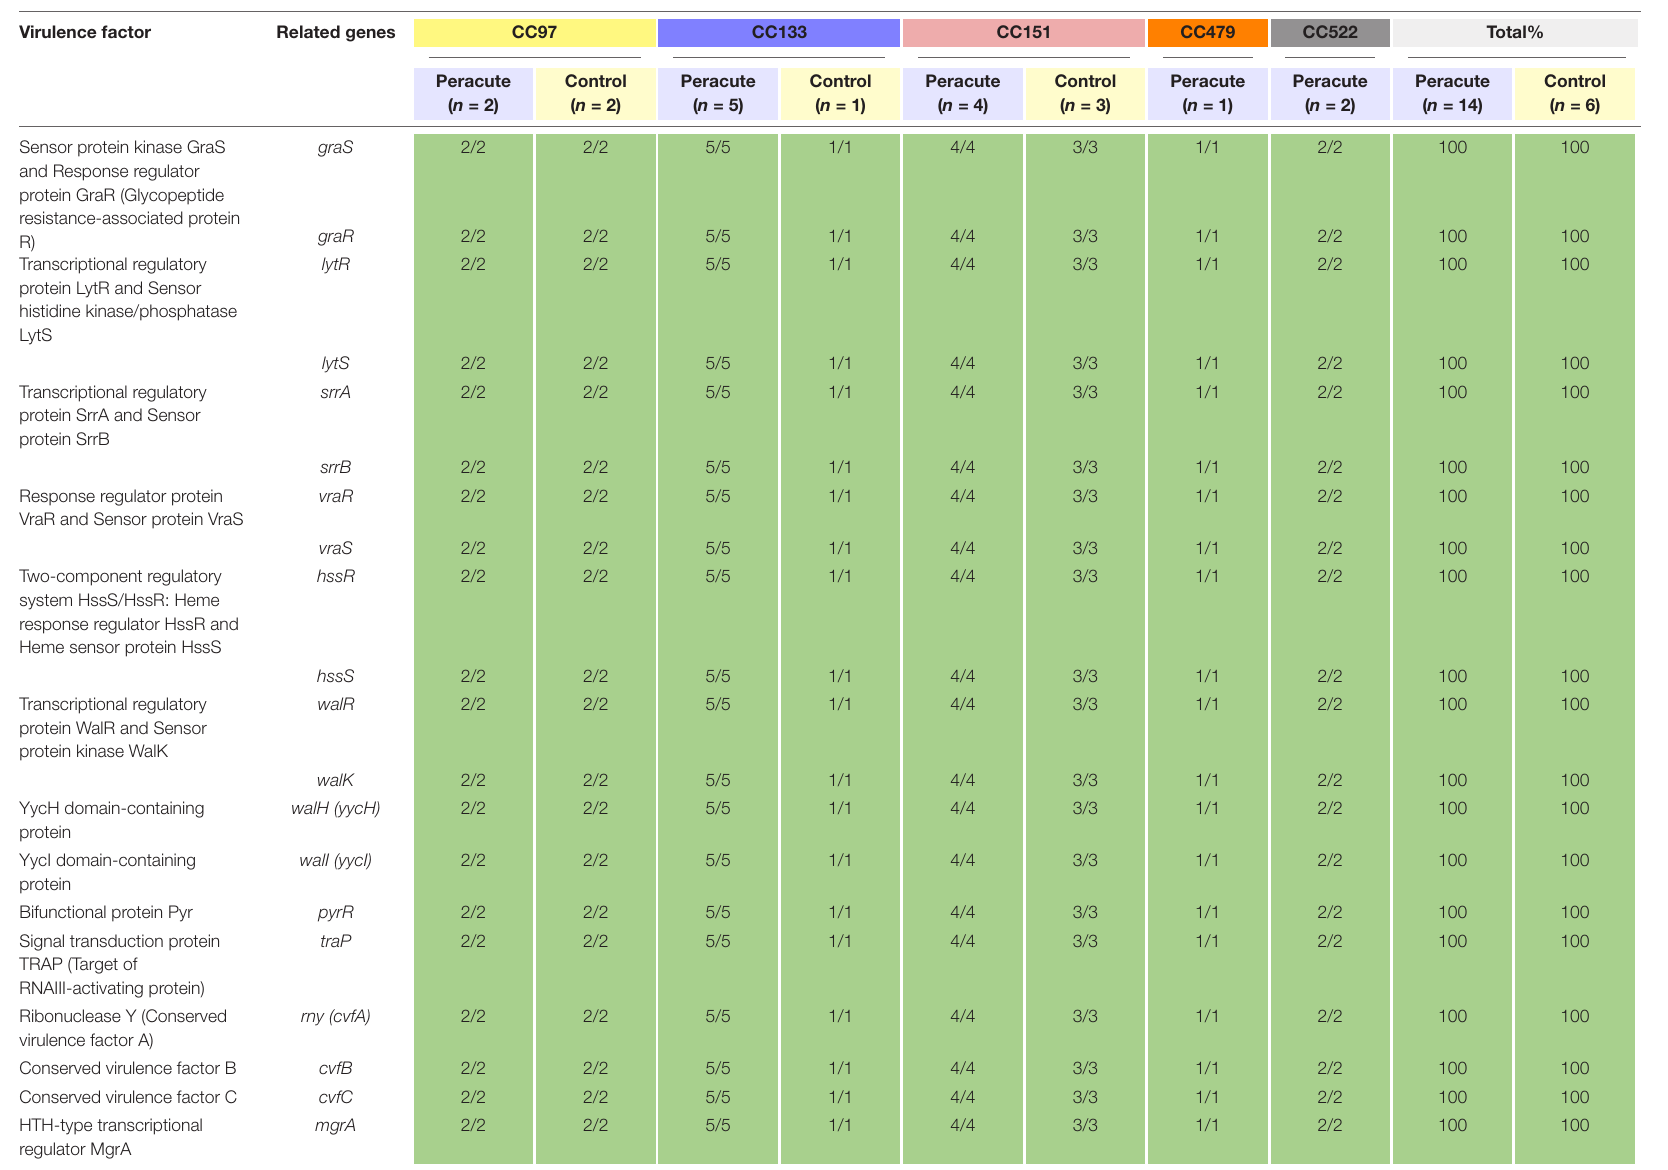
Darker green color indicates genes present in all isolates within a given group; lighter green indicates genes present in part of the isolates within a given group; red indicates genes not detected in any isolates within a given group. GTP, guanosine triphosphate; HTH, helix-turn-helix; CAAX, cysteine-2 aliphatic amino acids-terminal amino